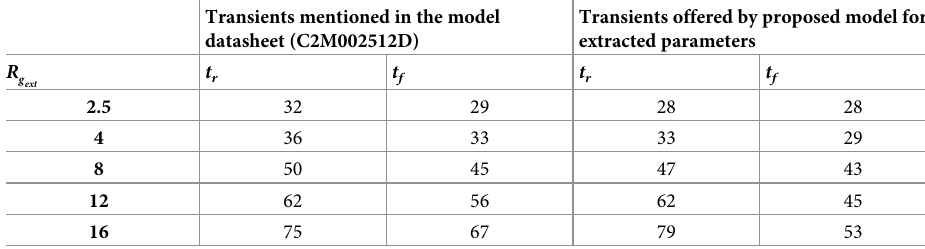
Fig 10. SiC nmos circuit for its transient analysis. https://doi.org/10.1371/journal.pone.0277331.g010 Table 2. Effect of changing external resistance over device transients.